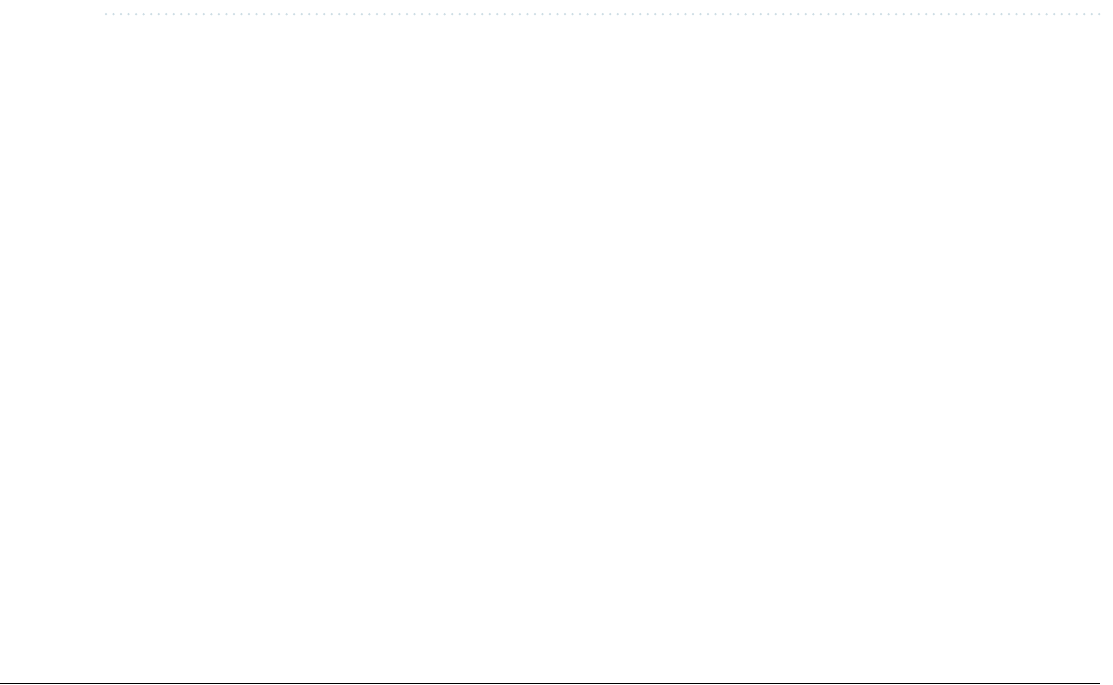
Figure 11. Experimental waveforms of ( a ) inductor L 1 voltage and current, ( b ) inductor L 2 voltage and current, and ( c ) SW